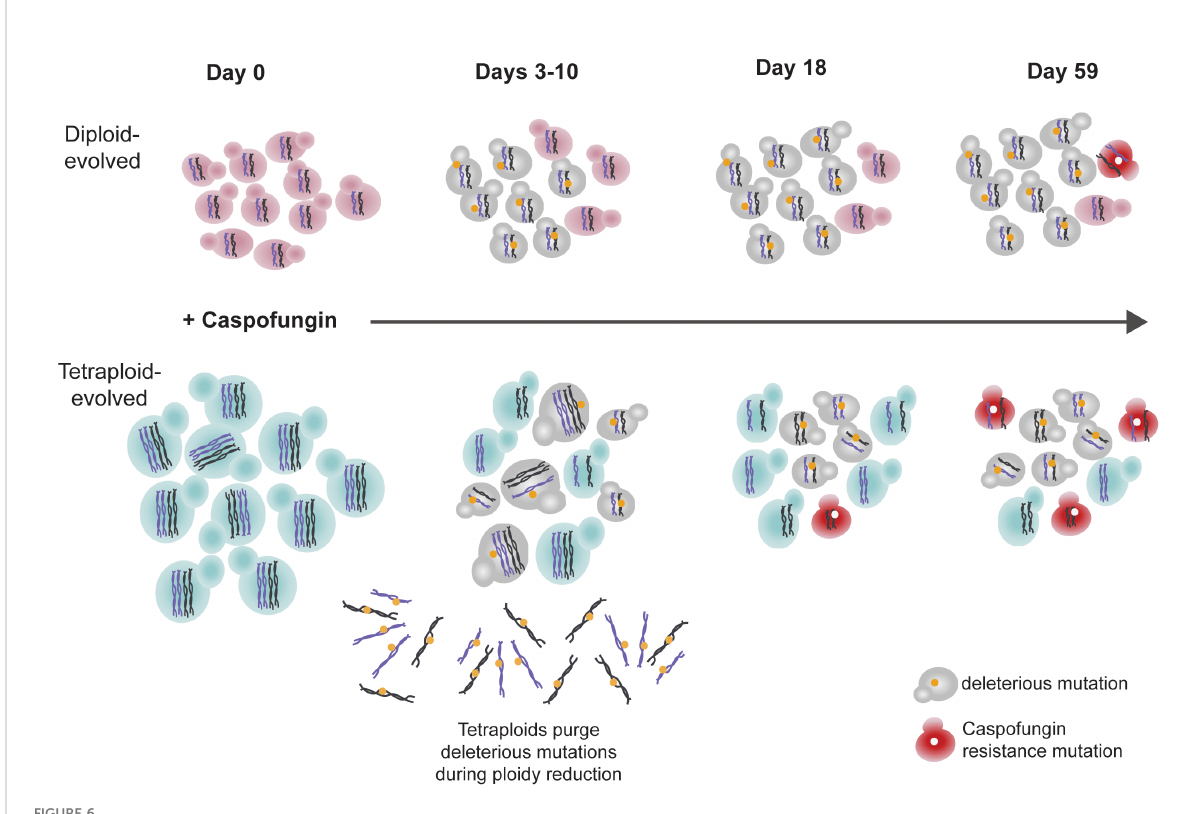
FIGURE 6 Ploidy reductions purge deleterious mutations and facilitate drug